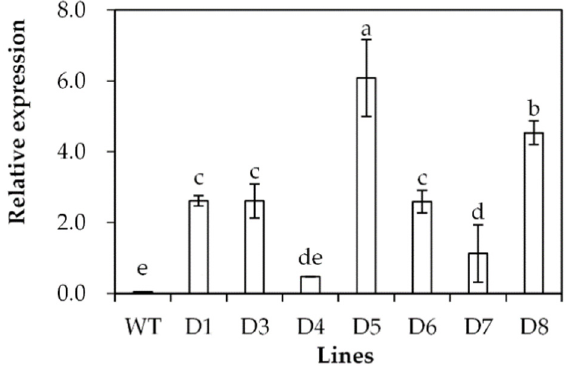
Figure 4. Analysis of SgDREB2C transcript in transgenic plants in comparison with the wild type (WT). The relative expression of SgDREB2C was evaluated using qPCR, and ACTIN was used as reference gene. Means of three replicates and standard errors are presented; the same letter above the column indicates no significant difference at p < 0.05.